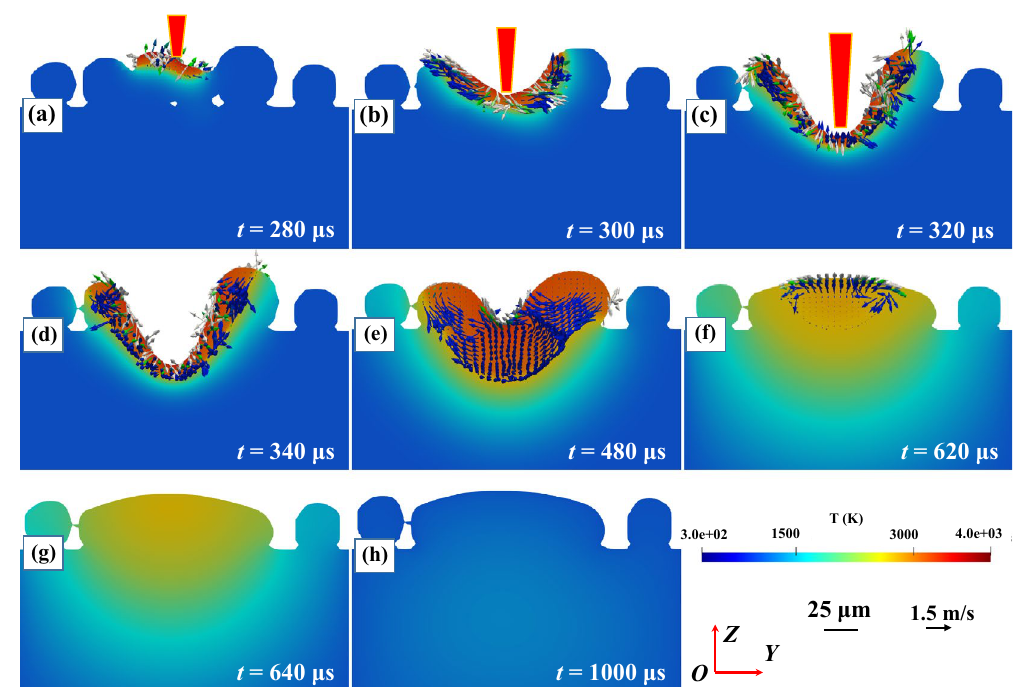
Figure 13 Serial cross-sections of LPBF tracks at 225